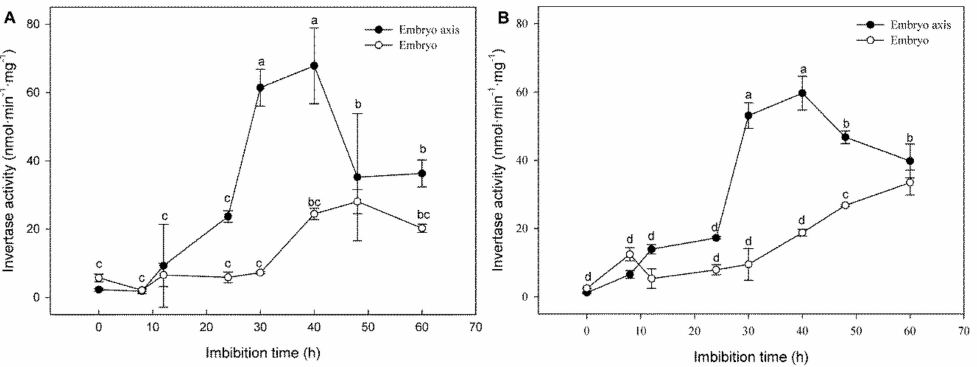
Figure 5. Invertase activity during germination. ( A ) Cell wall invertase, CWINV; ( B ) vacuolar invertase, VINV. The values correspond to the average of two independent experiments with triplicates ± SD. Di ff erent letters indicate statistically significant values according to the Tukey test, p < 0.05.